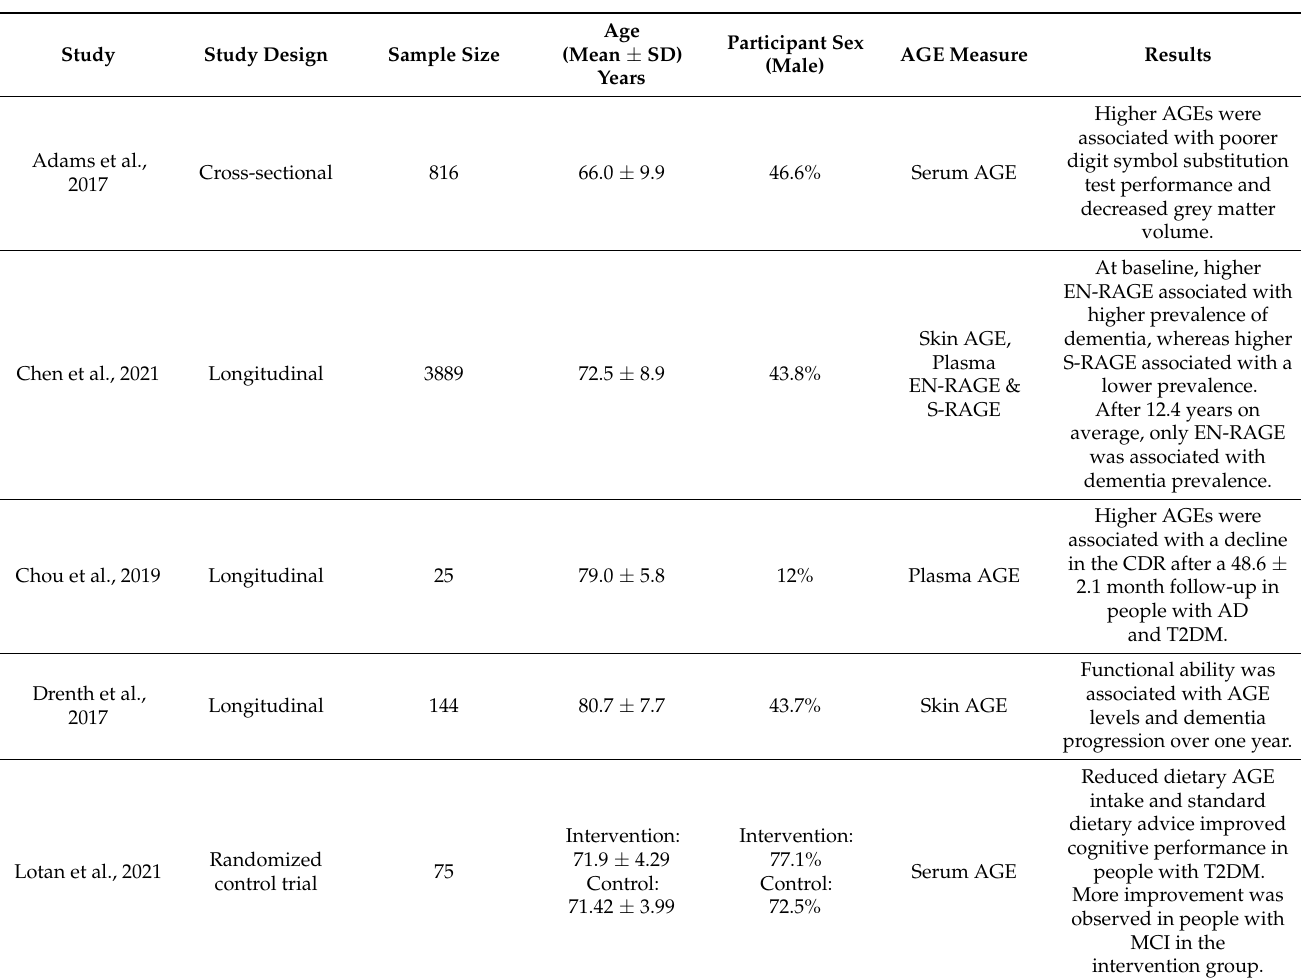
Table 1. Studies assessing the association between AGE concentrations and